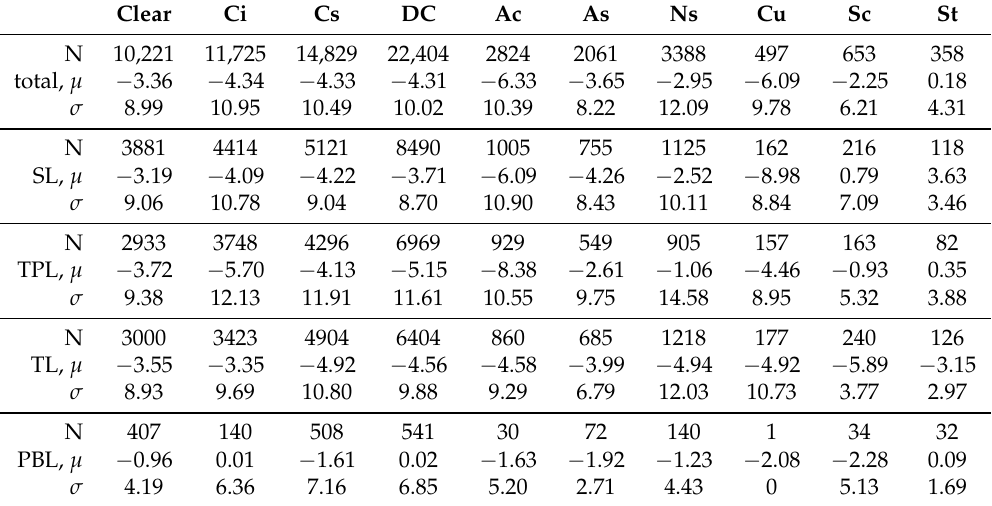
Table 2. The statistical parameters of the FY4A temperature with QC flags of “bad” or “very bad”. The number of cases N, mean bias ( µ ) and uncertainty (RMS, σ ) of the ensembles and sub-ensembles of the FY4A temperature for the different layers and 9 ISCCP cloud types and clear-sky condition. The units of bias and uncertainties are K. Total: from the 10 hPa to surface; SL: Stratosphere Layer; TPL: TropoPause Layer; TL: Troposphere Layer; PBL: Planetary Boundary Layer. Ci: Cirrus,